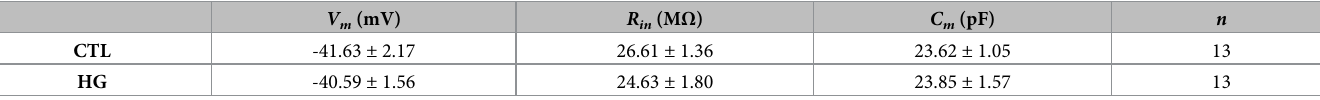
Table 2. Passive membrane properties for cultured DRG neurons from RAGE KO mice.